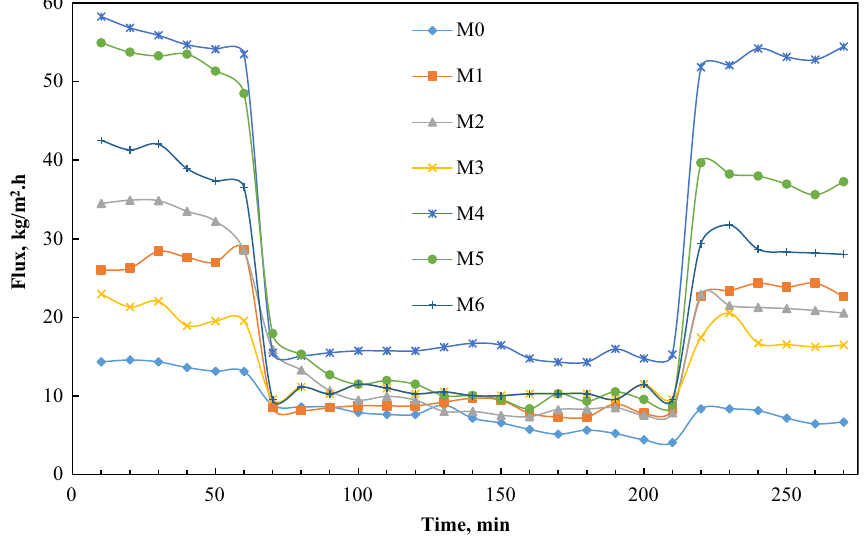
Fig. 7 Fouling behavior for the